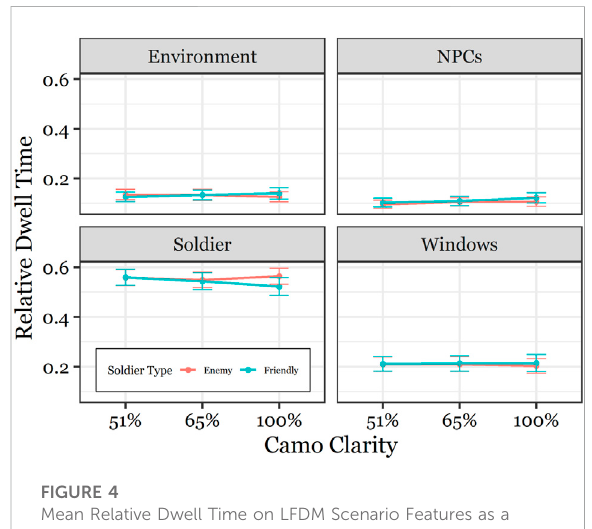
FIGURE 4 Mean Relative Dwell Time on LFDM Scenario Features as a function ofCamo Clarity and SoldierType. Participants dwelled on the advancing enemy Soldiers relatively longer than Friendly Soldiers, when they wore the clearest camo pattern (100CC) ( p < 0.01). Error bars depict standard error of the